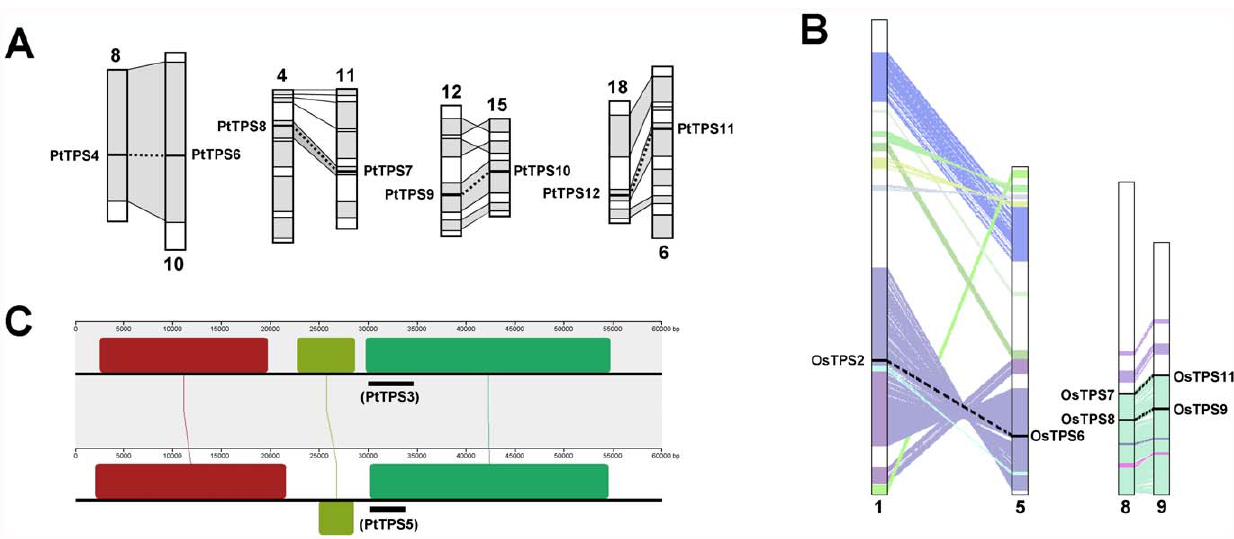
Figure 4. Duplicate gene pairs created by segmental duplication in Populus (A) and rice (B). Comparisons of the 60-kb flanking genomic regions of the paralogous gene pair PtTPS3/5 (C). In (A), homologous genome blocks are shaded with grey and connected with lines. In (B), homologous genome blocks are shaded with colour. In (C), genome sequences were aligned using the progressive Mauve algorithm of Mauve v2.3.1 [29] with default parameters. Locally collinear blocks are indicated as same-coloured boxes and connected by thin coloured lines.